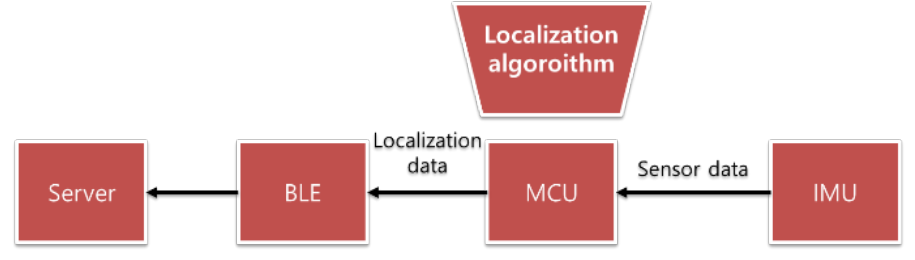
Figure 2. Overview of the embedded hardware for indoor positioning system.